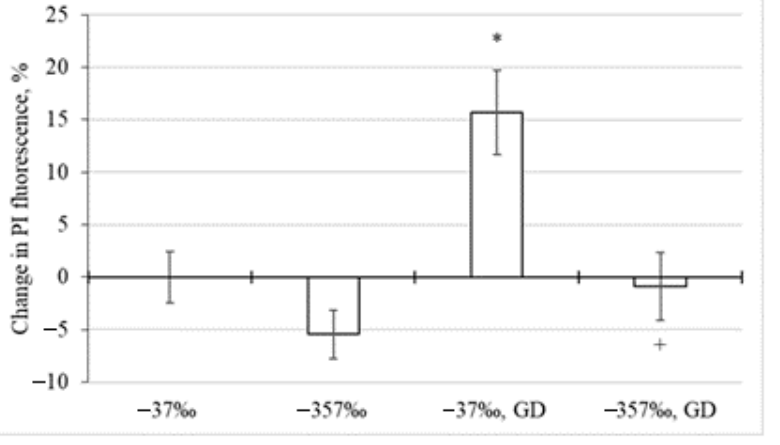
Figure 1. Changes in the neuronal death rate in the cerebellar neuronal-glial cell cultures during glucose deprivation (GD) depending on the concentration of deuterium in the incubation medium ( δ 2 H = − 37‰, − 357‰), determined by the fluorescence of propidium iodide (PI). Data are presented as M ± m. *— p < 0.05 o control ( δ 2 H = − 37‰), +— p < 0.05 к δ 2 H = − 357‰ with